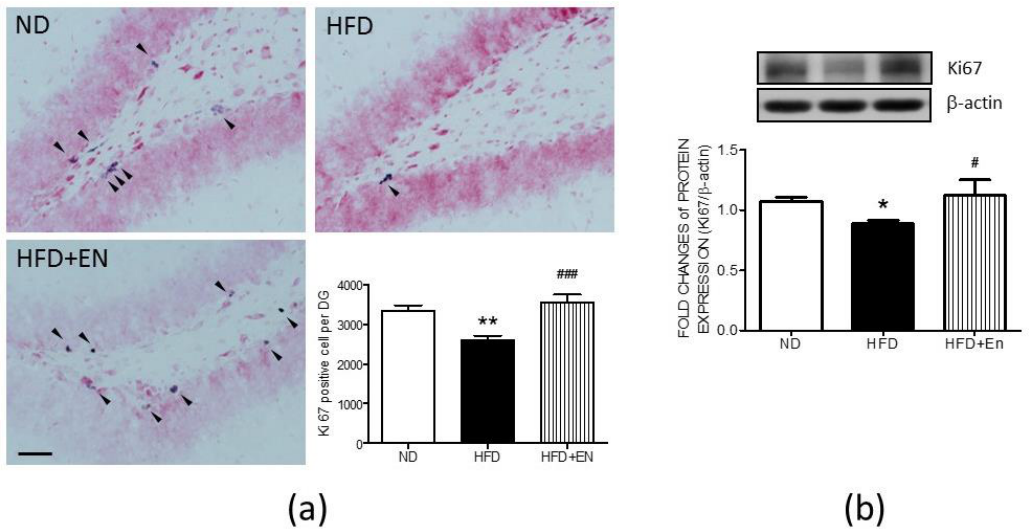
Figure 6. Enriched housing counteracted maternal HFD suppression of Ki67 expression and cell proliferation in the hippocampus of the HFD group. ( a ) Representative images of Ki67-positive cells and cell numbers in the dentate gyrus, and ( b ) protein expression of Ki67 in the hippocampus of female o ff spring at 12 weeks old. Values were mean ± SEM, ND: n = 12; HFD: n = 12; HFD + En: n = 6. * p < 0.05, ** p < 0.01, indicate significant di ff erences from the ND group and # p < 0.05 , ### p < 0.001 indicate significant di ff erences from the HFD group using a post-hoc Tukey’s multiple range test. ND: female o ff spring exposed to a maternal normal diet; HFD: female o ff spring exposed to a maternal high-fructose diet; enriched housing for 4 weeks (En). β -actin was used as the internal loading control. Arrowhead: Ki67-positive cells. Scale bar: 50 µ m.